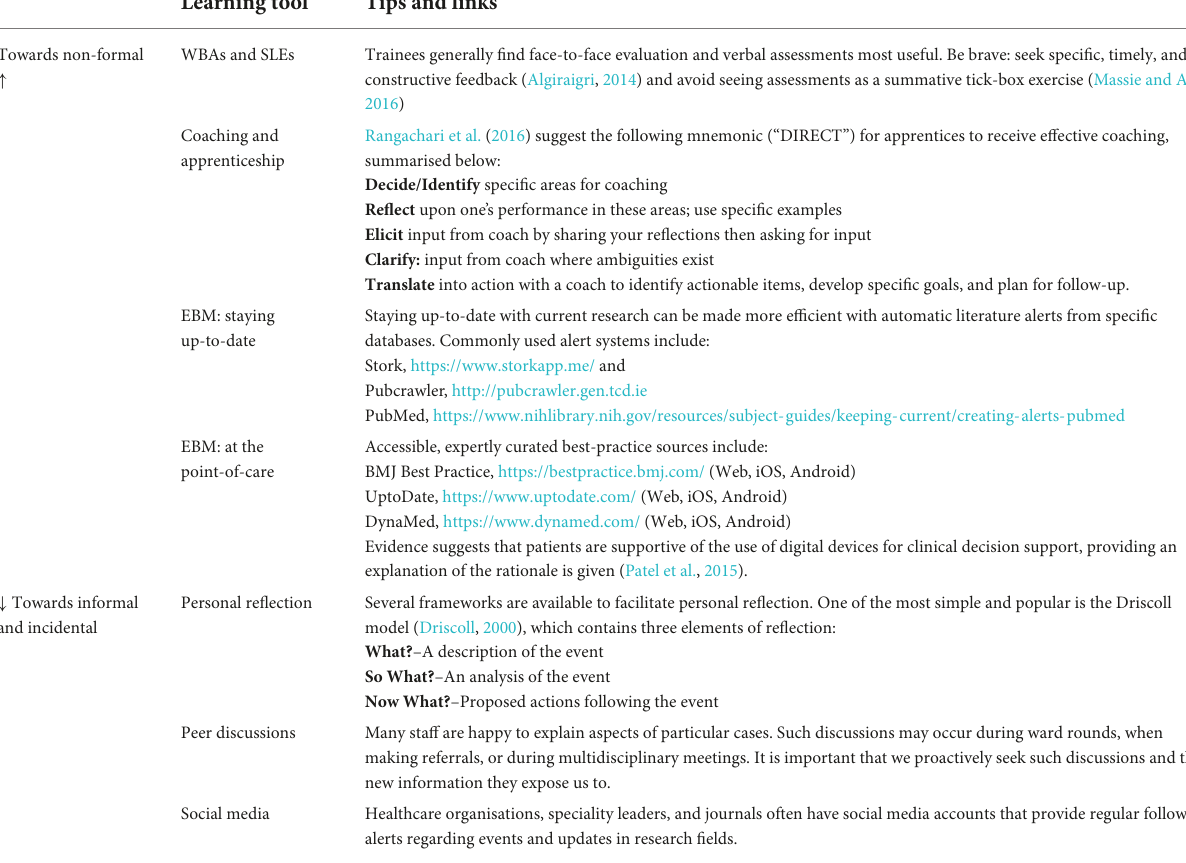
TABLE 3 Non-formal, informal, and incidental learning